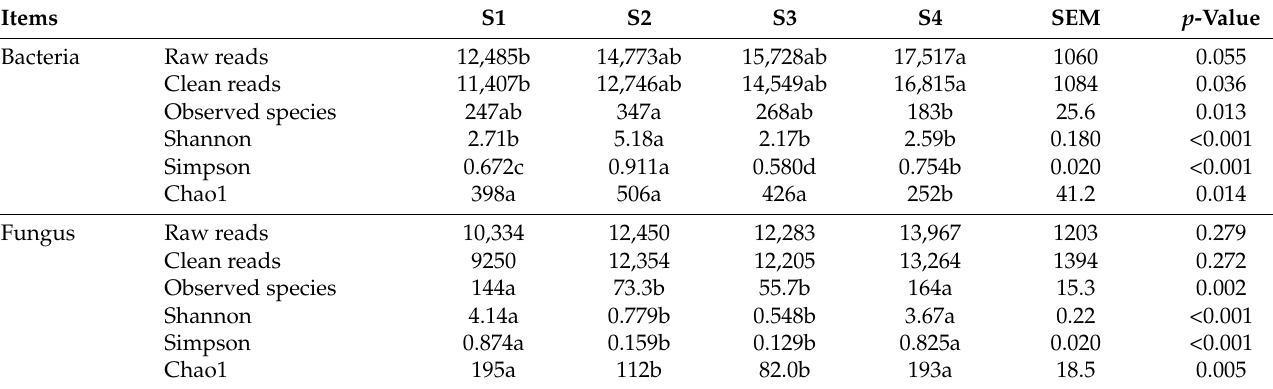
Table 3. Sequencing data and alpha diversity of bacteria and fungi in whole-plant corn silage (n =